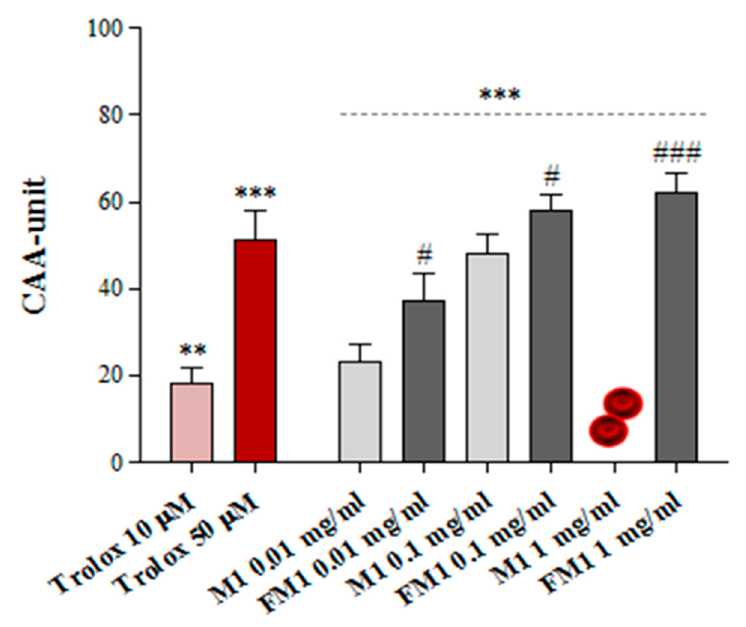
Figure 9. E ff ects of unfermented (M1) and fermented (FM1) millet extracts at di ff erent concentrations (0.01, 0.1, and 1 mg / mL) on the cellular antioxidant activity (CAA) of human erythrocytes under oxidative conditions. Trolox was used as a reference standard. Data are expressed as the mean values ± SD of independent experiments performed on three di ff erent subjects One-way ANOVA with Dunnett’s multiple comparison test: * significantly di ff erent from CNT, AAPH treated cells (CAA = 0), ** p ≤ 0.01, *** p ≤ 0.001. Unpaired t-test: # significantly di ff erent from the respective non fermented flour, # p ≤ 0.05, ## p ≤ 0.01, ### p ≤ 0.001.